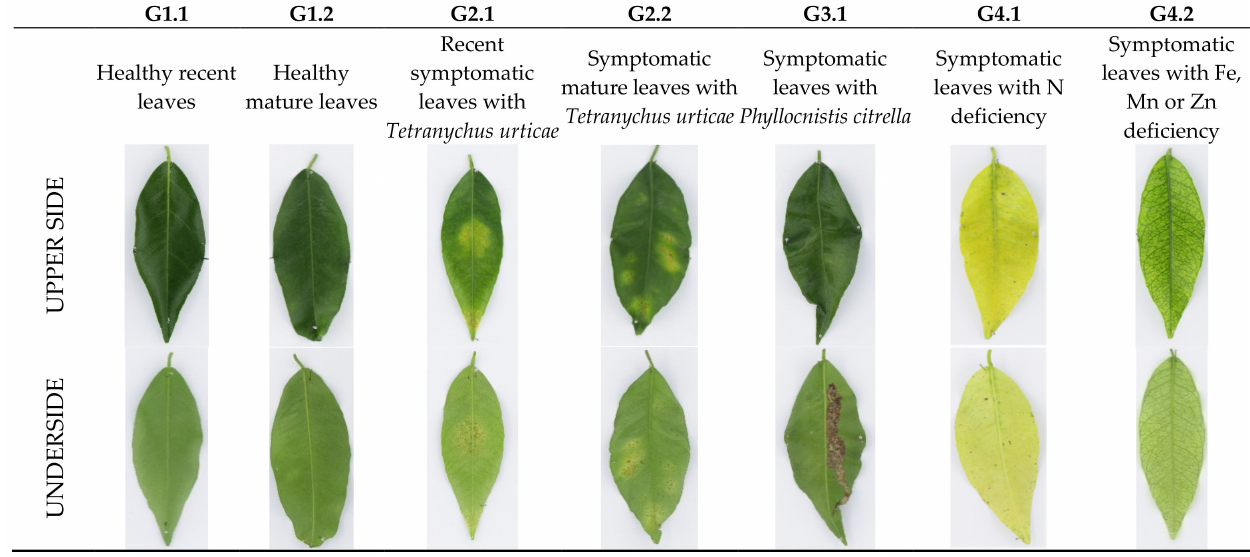
Figure 1. Images of the leaves (upper and underside of the leaf) for each